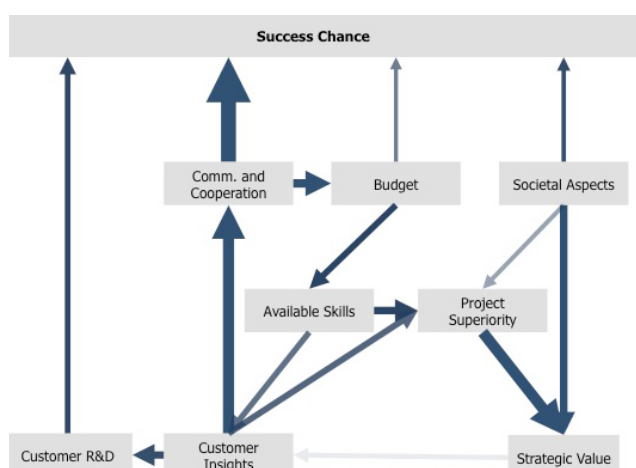
Fig. 3. Result of Structural Equation Modeling, depicting the relation between the KPIs and their relation to innovation project success.